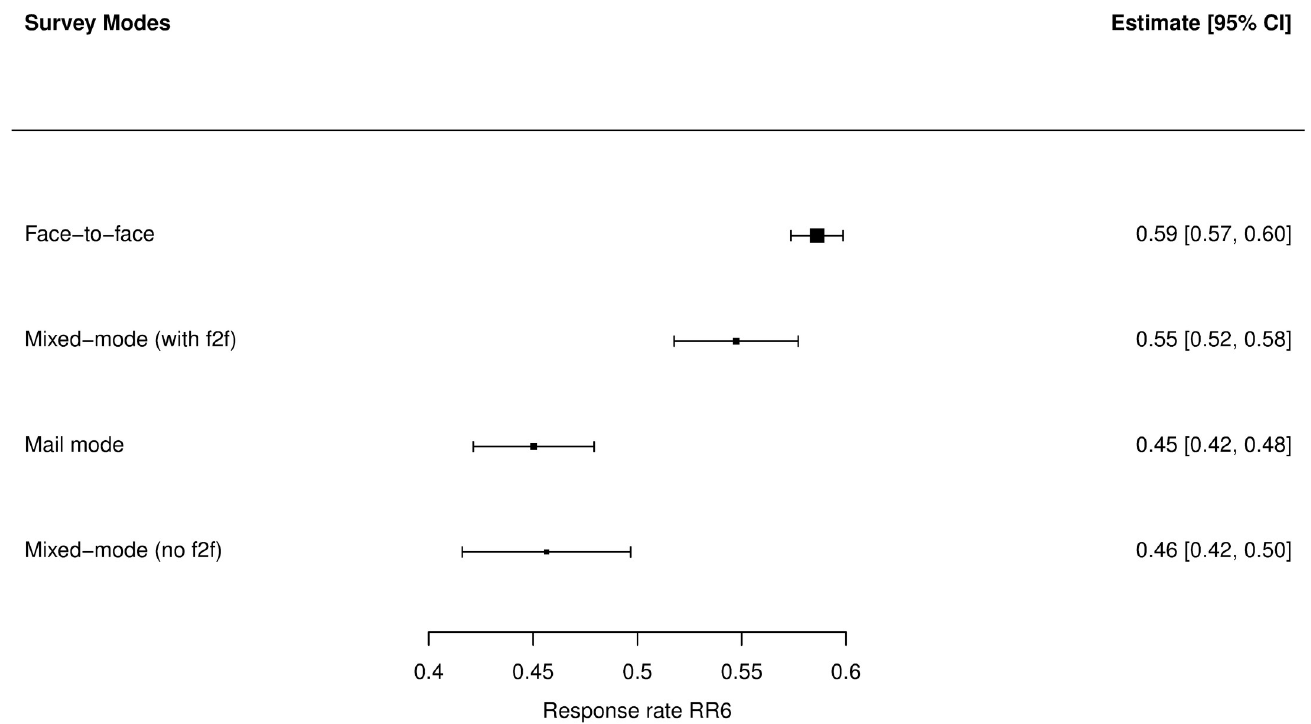
Fig 3. Distribution of RR6 values of surveys in the dataset by survey modes—forest plot. N = 795.